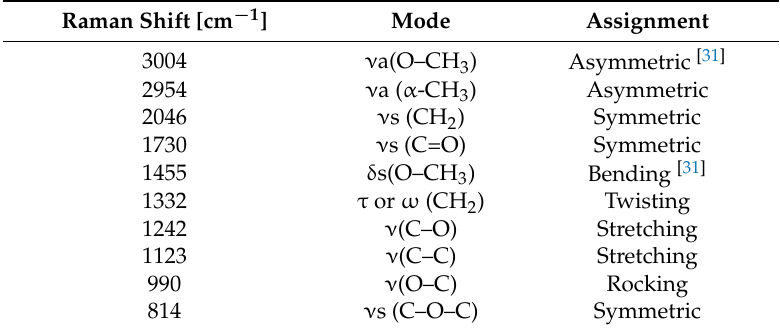
Figure 4. ( a ) Raman spectra of PMMA bulk film (760 nm) and bare quartz substrate. ( b ) Raman spectra (normalized with the intensity at 2949 cm − 1 and 2953 cm − 1 ) of PMMA ultrathin film (25 nm) supported on quartz (blue line) and silver (red line) substrates. ( c ) Raman enhancement factors of PMMA bulk film (760 nm, black line) and thin film (25 nm, red line) supported on silver substrates. ( d ) Possible structure of adsorbed ester group of PMMA molecule supported on silver substrates. Table 1. Assignments of Raman spectra of PMMA bulk film on quartz substrate.